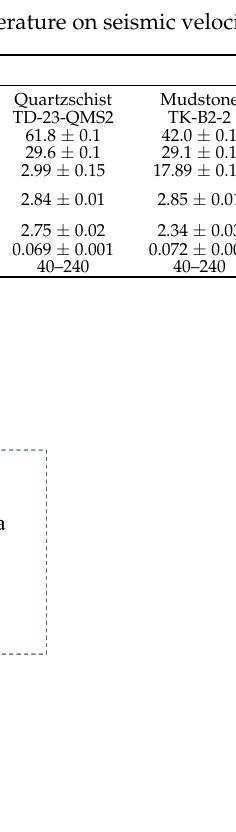
Figure 3. Schematic of the set-up used for assessing the effect of temperature on seismic velocity.